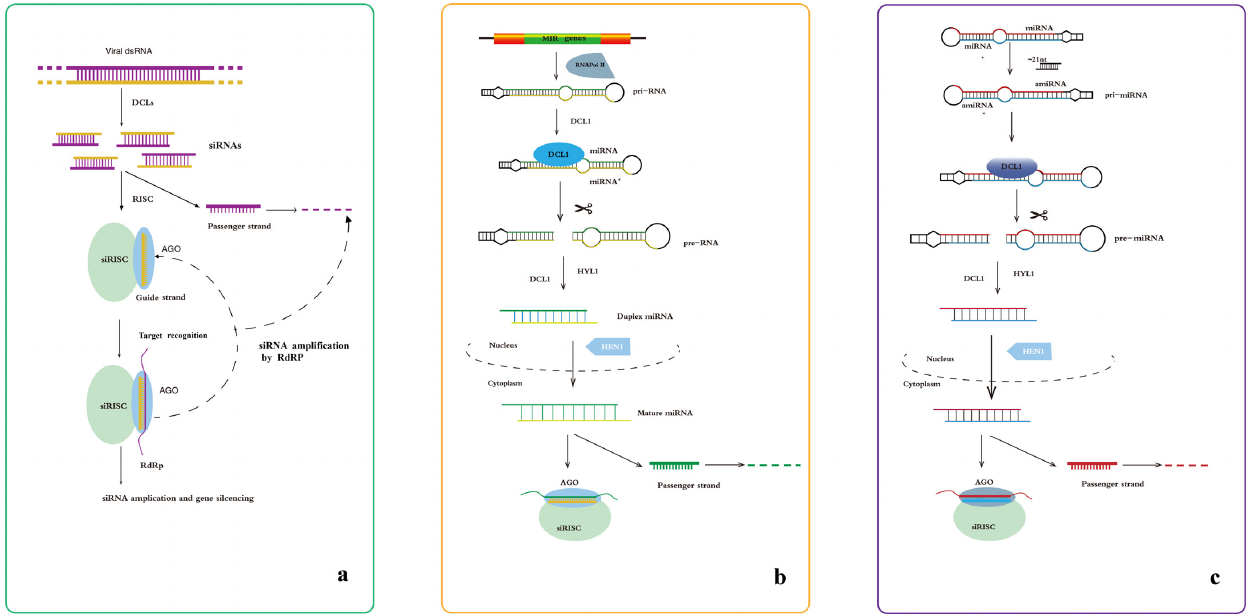
Figure 1. Antiviral RNA silencing pathway in plants. ( a ) The antiviral siRNA pathway. First, the dsRNA structures of viral RNAs are processed by Dicer-like proteins into several siRNA fragments. The guide strand of siRNA (orange) can assemble into functional siRISC, and the passenger strand (purple) is ejected and degraded. All the forms of siRISC contain siRNA bound to an AGO protein. Target RNAs are then recognized by base pairing, and the siRNA populations that engage a target can be amplified by the action of RdRP enzymes, strengthening and perpetuating the silencing response. ( b ) The antiviral miRNA pathway. Primary miRNA (pri-RNA), produced from MIR genes by RNA Pol II, is diced into pre-miRNA by DCL1. Pre-miRNA is further processed by DCL1 and other accessory proteins into duplex miRNA, which is methylated by HEN1 into mature miRNA duplex and transported to the cytoplasm. The guide strand of mature miRNA associates with RISC that consists of AGO1. ( c ) The antiviral amiRNA pathway. The amiRNA transgene expresses a monocistronic MIRNA precursor sequentially processed into an amiRNA targeting a single site in a single viral RNA, and the consequent steps are same as the antiviral miRNA pathway. Several studies have revealed the efficiency of RNA silencing in controlling viral diseases in